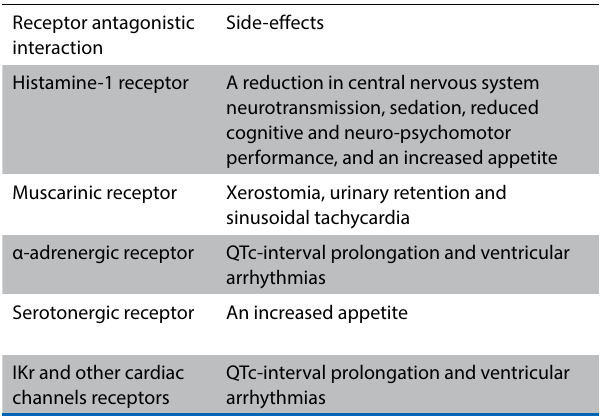
Table II: The adverse effects of first-generation histamine 1 antihistamines, as reflected by receptor activity. 36 Receptor antagonistic interaction